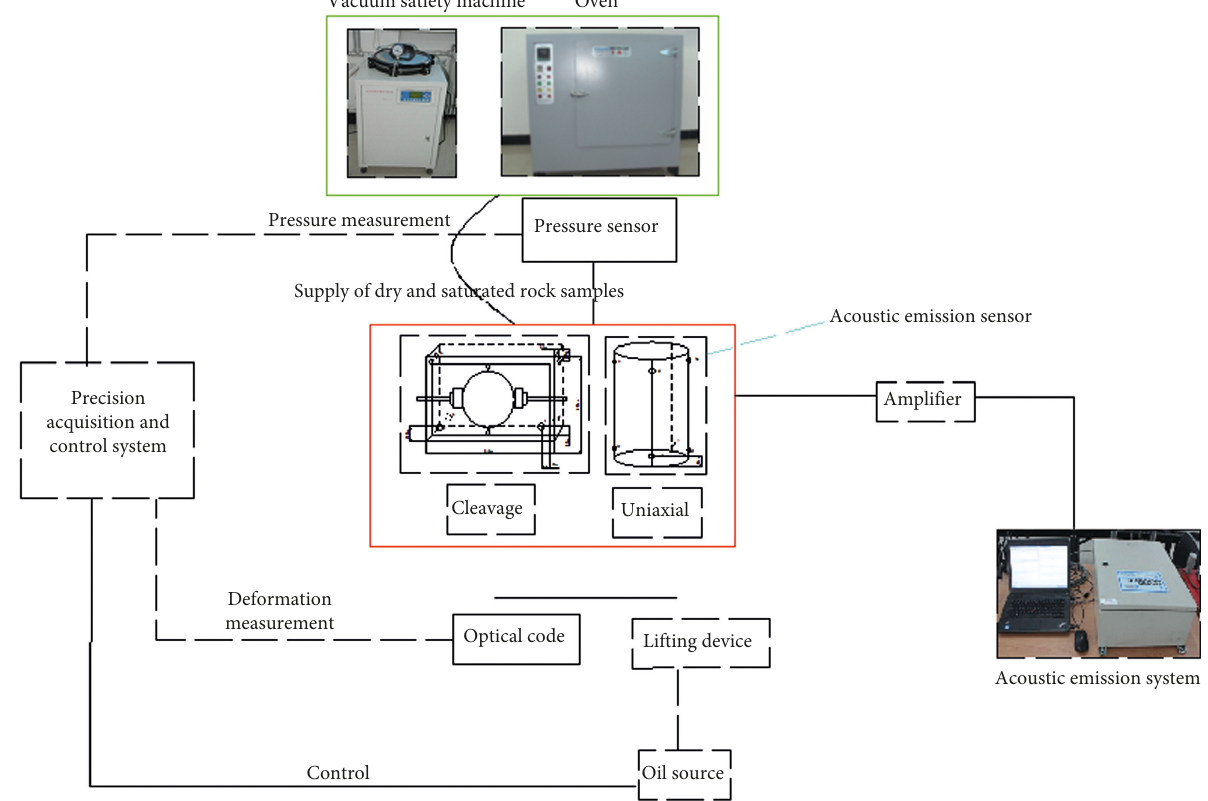
Figure 2: Rock mechanics experimental